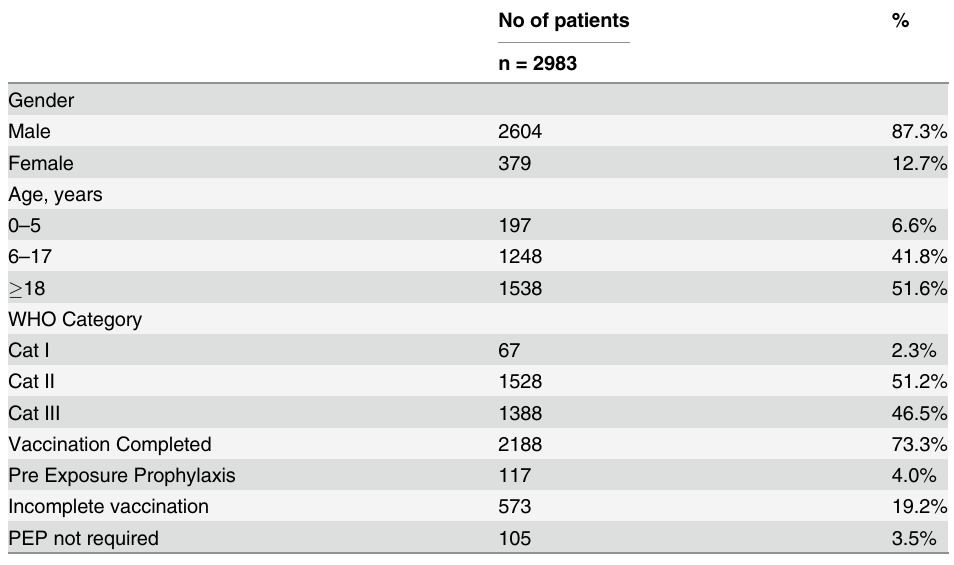
Table 1. Profile of bite victim throughput seen at The Indus Hospital Rabies Prevention Center (July 2013-June 2014).